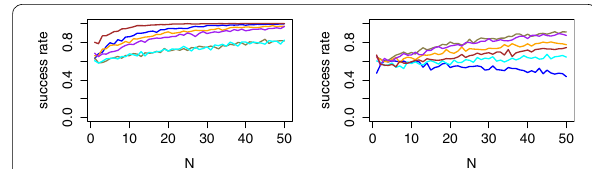
Fig. 11 Exemplary success rates per tag value for “all against one” profiling: (left: User 3, right: User 4)